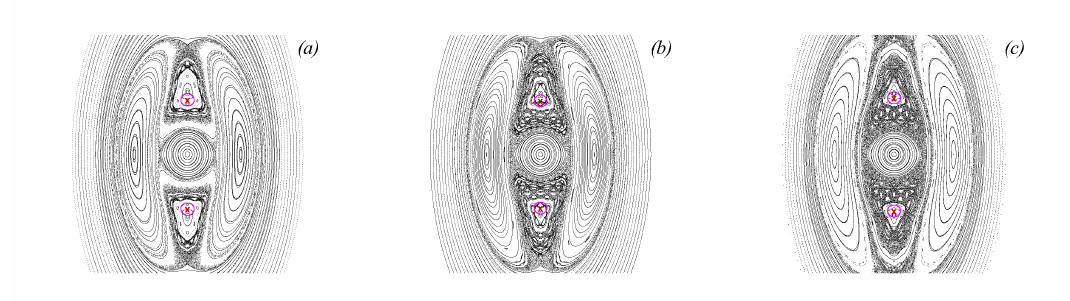
Figure 27. Poincaré maps for the upper-layer advection system perturbed by two lower-layer vortices of equal weak strength µ when S 0 = − 0.01, Ω 0 = − 0.02 and the shift of the vortices from their stationary positions is 0.1. The sequence shows a reconnection of the chaotic regions associated with two resonance series 1 : 2 as the vortex strengths vary: ( a ) µ = 0.045; ( b ) µ = 0.0475; and ( c ) µ =